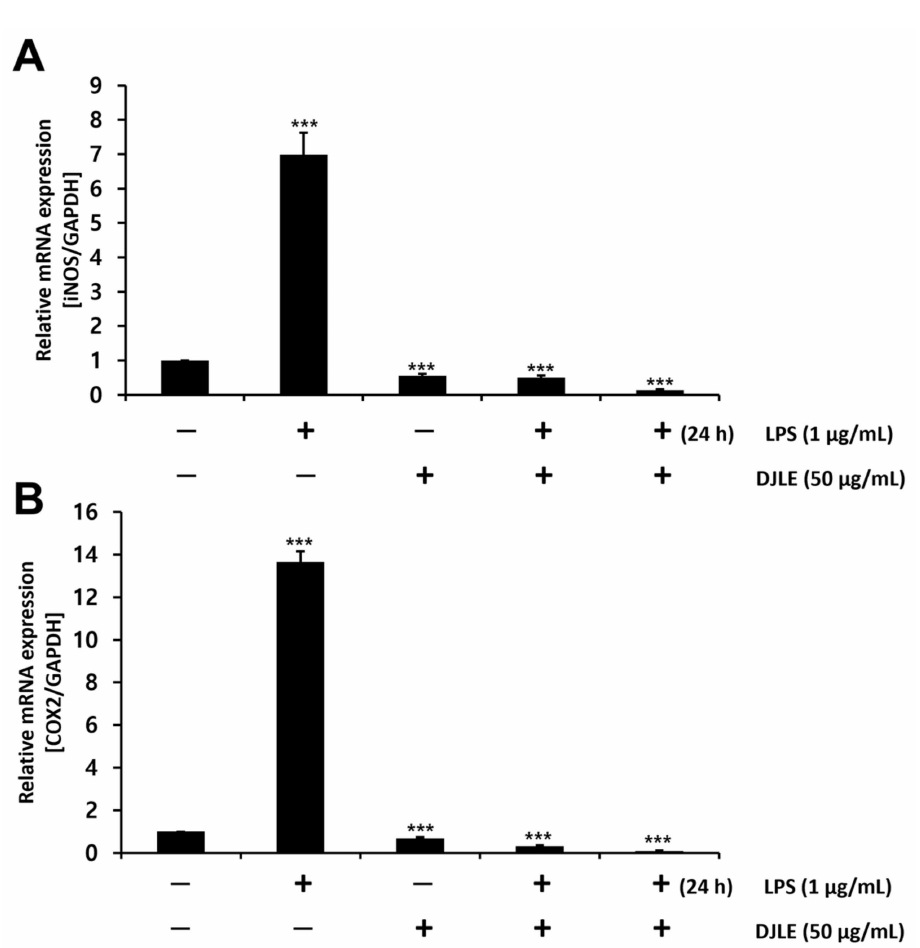
Figure 6. Effect of Daphne jejudoensis leaf extract (DJLE) on the gene expression of inducible nitric oxide synthase (iNOS) ( A ) and cyclooxygenase (COX)-2 ( B ) in lipopolysaccharide (LPS)-stimulated human periodontal ligament cells. *** p < 0.001 vs.